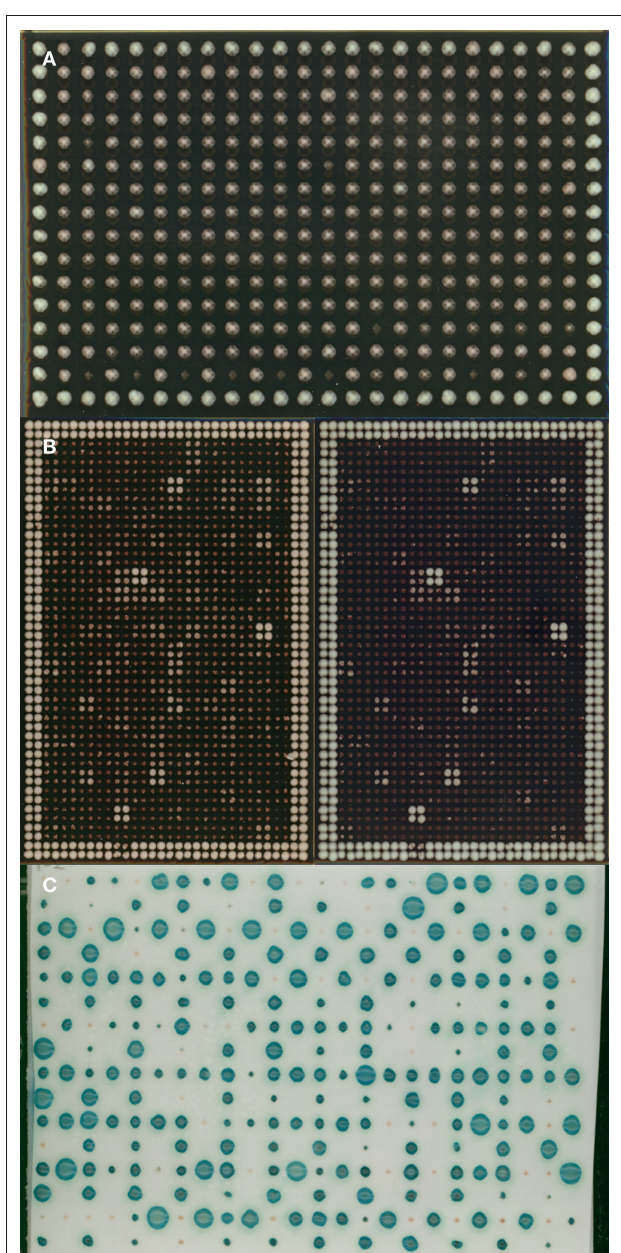
Figure 2 | pPPis detected in the AMPv2 screen. (A) Selection of diploid cells on DS media supplemented with adenine and histidine. (B) Successful mating (His3, Ade2 positive) was selected on IS-0 media without met (right) and IS-500 with 500 μM met (left). (C) Representative image of the β -galactosidase assay performed on yeast grown on nitrocellulose-overlaid agar media. Positive pairs were picked by hand, re-arrayed and tested for the LacZ marker. Plate size for (A–C) was 125 mm × 85